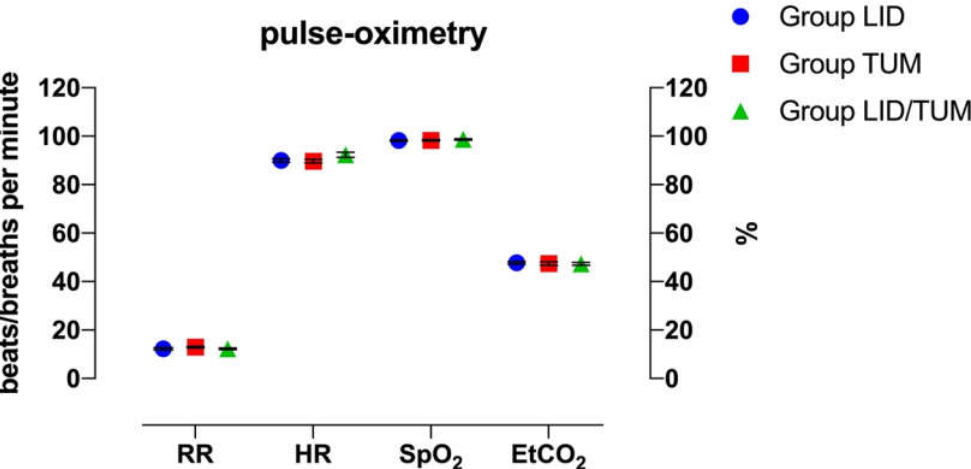
Figure 3. Mean values ± standard error of heart rate (HR), respiratory rate (RR), arterial oxygen saturation (SpO 2 ) and end-tidal partial pressure of CO 2 (E t CO 2 ) during anesthesia procedures in the three groups. LID: Lidocaine group; TUM: Tumescent anesthesia group; LID/TUM: Lidocaine/Tumescent anesthesia group.